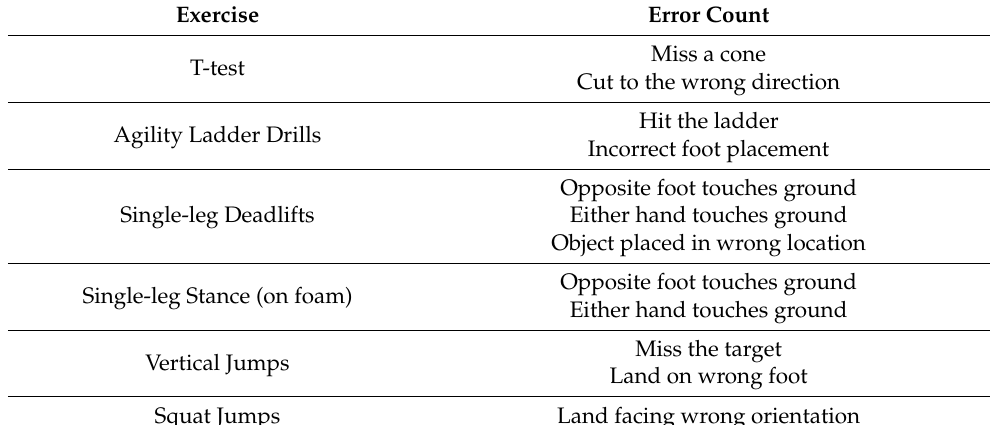
Table 4. Error Scoring System Used to Assess Behavioral Performance